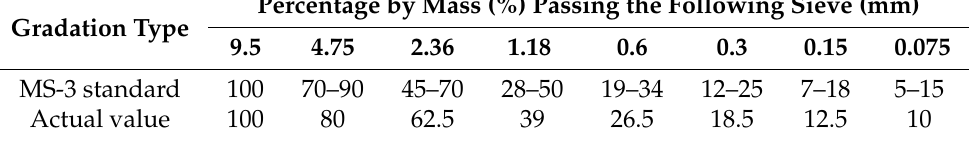
Table 2. Mineral aggravate gradation of microsurfacing.